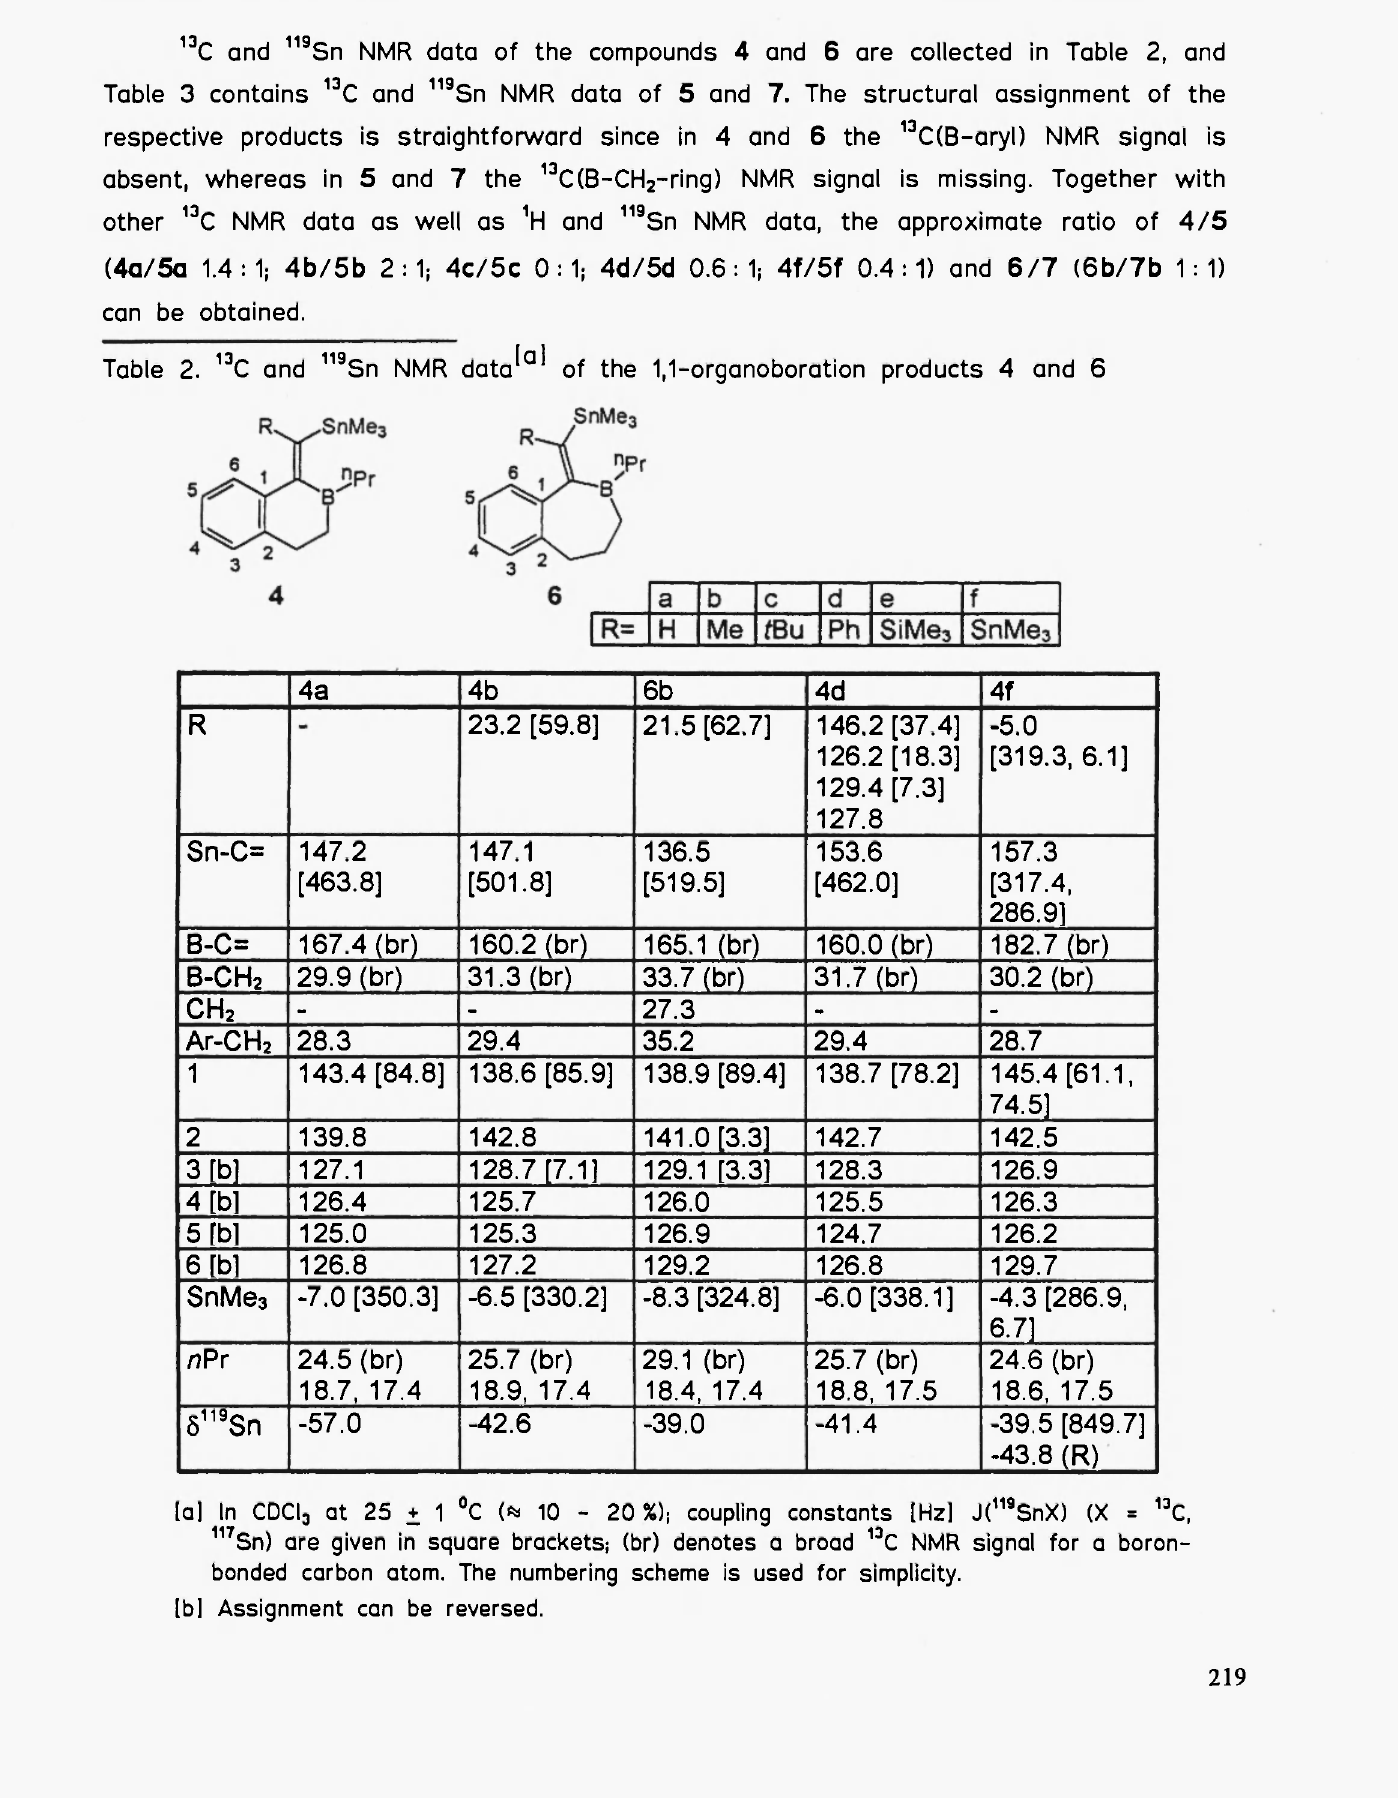
Table 2. 13 C and 119 Sn NMR data la! of the 1,1-organoboration products 4 and